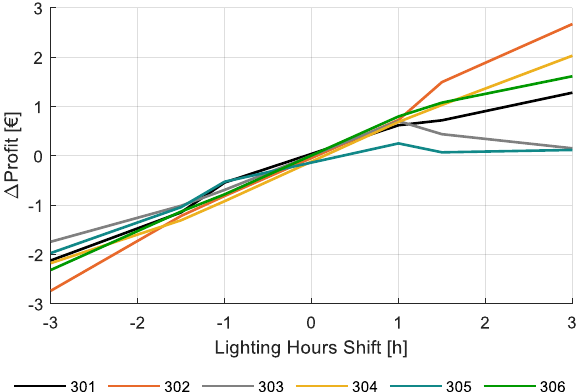
Figure 20. Change in simulated net profit ( € / m 2 ) for varying temperature shifts − 2 to + 2 ◦ C on the applied heating temperature strategy for the different greenhouse compartments (301 – 306).